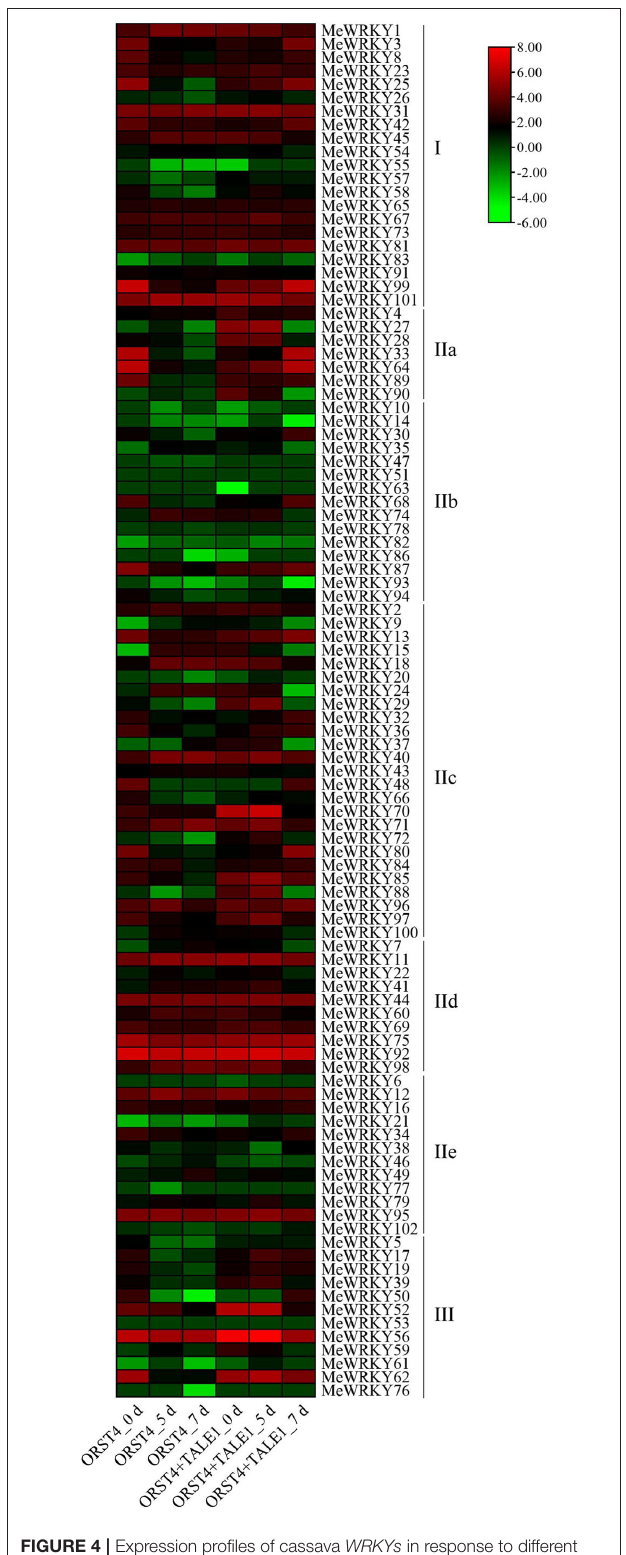
FIGURE 4 | Expression profiles of cassava WRKYs in response to different Xam ( Xanthomonas axonopodis pv. manihotis ) strains. The 12 transcriptome